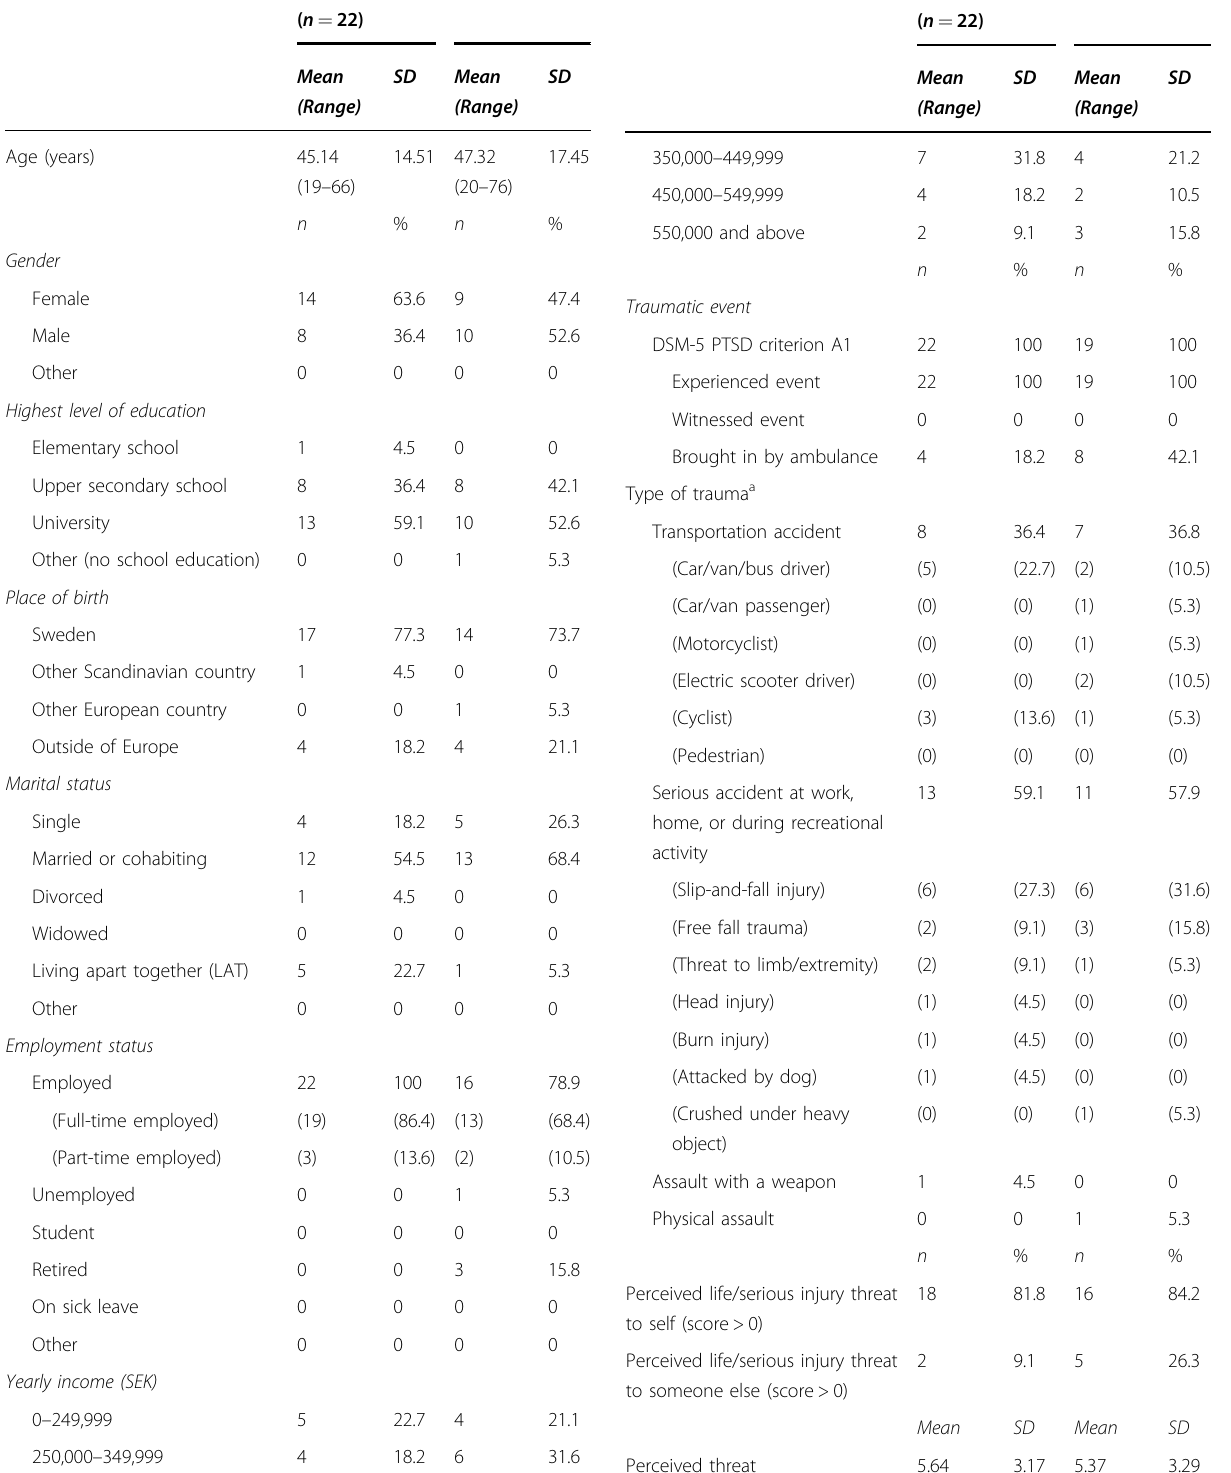
Table 2 Participant characteristics per